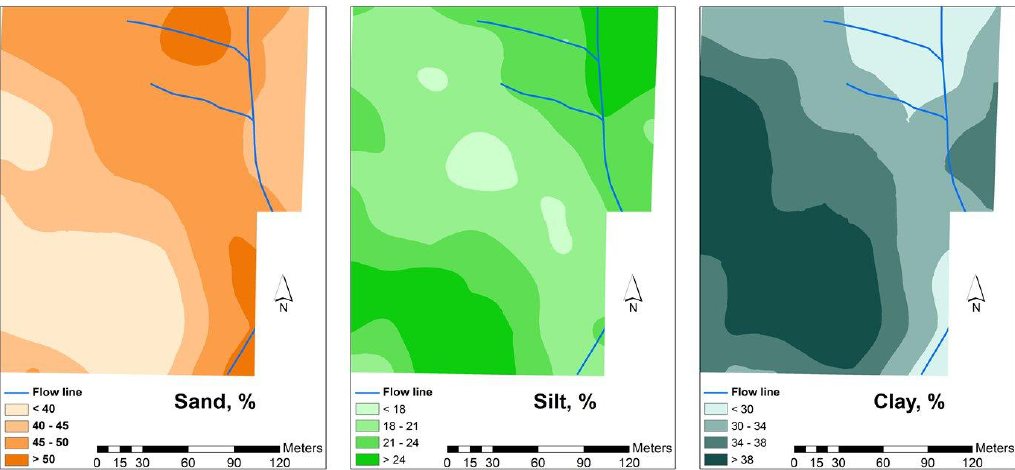
Figure 4. Sand, silt and clay content in the soil of the experimental field